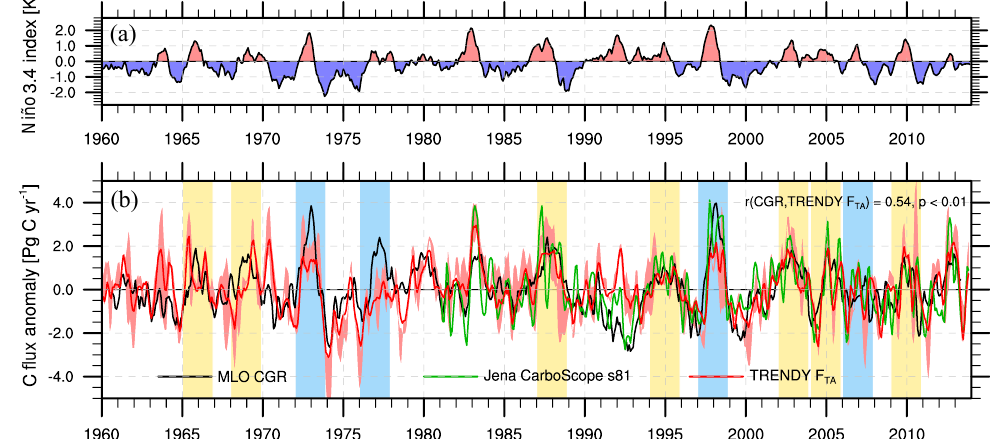
Figure 1. Interannual variability in the Niño3.4 index and the carbon cycle. (a) Niño3.4. (b) Mauna Loa (MLO) CO 2 growth rate (CGR, black line), as well as TRENDY multi-model median (red line) and Jena inversion (green line) of the global land–atmosphere carbon flux ( F TA ; a positive value means flux into the atmosphere; units: PgCyr − 1 ), which were further smoothed by the 3-month running average. The light red shading represents the area between the 5 and 95% percentiles of the TRENDY simulations. The bars represent the El Niño events selected for this study, with the EP El Niño in blue and the CP El Niño in